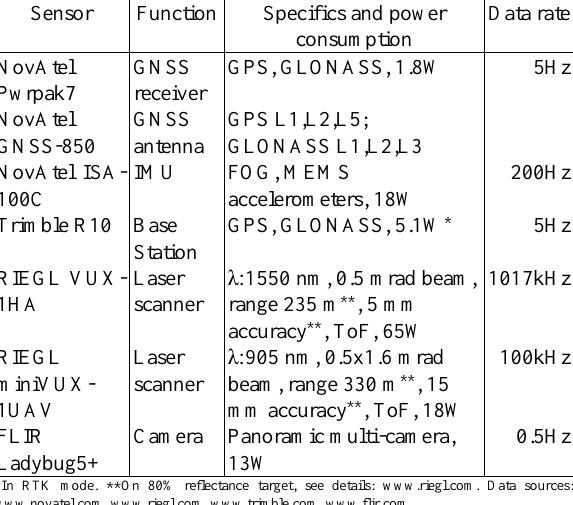
Table 1. AkhkaR4DW subsystems, their function, specifics, power consumption and data rates used in the